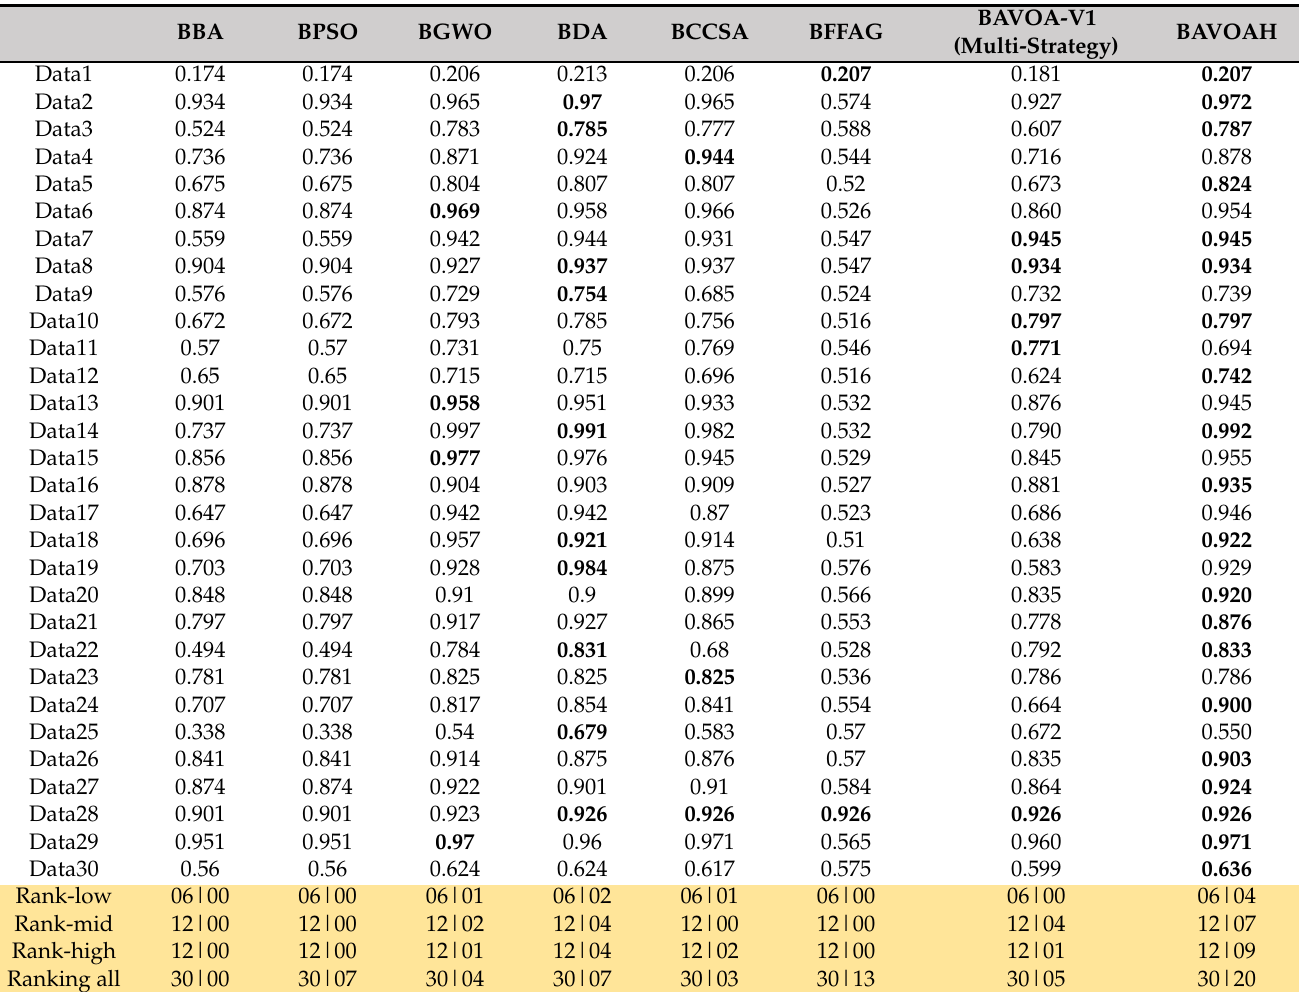
Table 6. Comparison of the proposed BAOVAH (hyper-heuristic) and BAVOA-V1 (multi-strategy) approach based on the average accuracy